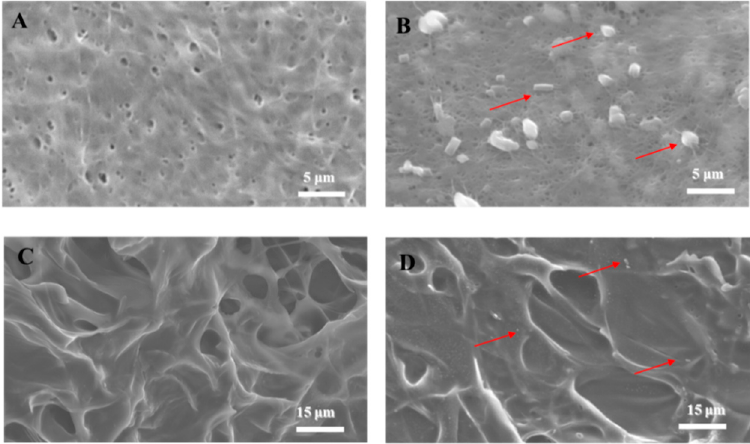
Figure 2. SEM analysis. ( A ) BC scaffold, ( B ) BC/RSV scaffold, ( C ) COL scaffold, and ( D ) COL/RSV scaffold. Red arrows indicate RSV particles. Scale bars = 5 μ m ( A , B ) and 15 μ m ( C , D ).